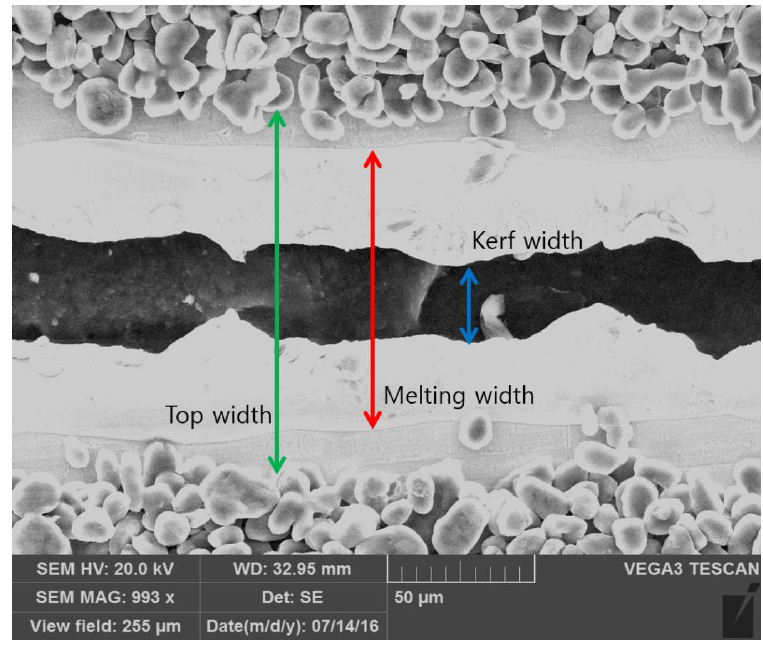
Figure 1. Definition of top, melting, and kerf width.